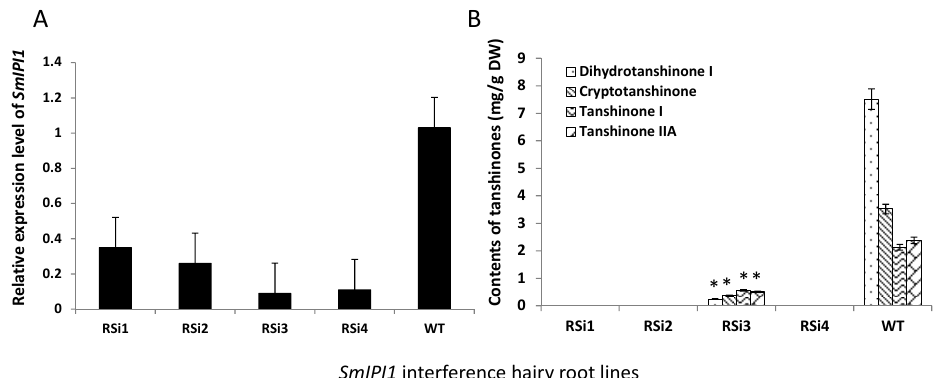
Figure 8. ( A ) The mRNA expression level SmIPI1 in RNAi hairy root lines and WT; ( B ) Contents of four kinds of tanshinones between RNA interference lines and WT. The values are means ± SD of triplicate analyses. *, significant difference at p < 0.05.